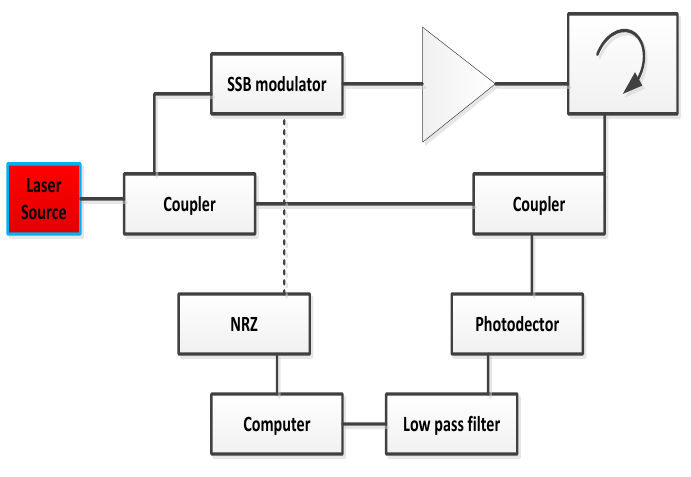
Figure 5. OTDR-coherent FDM-based vibration sensing classifications.